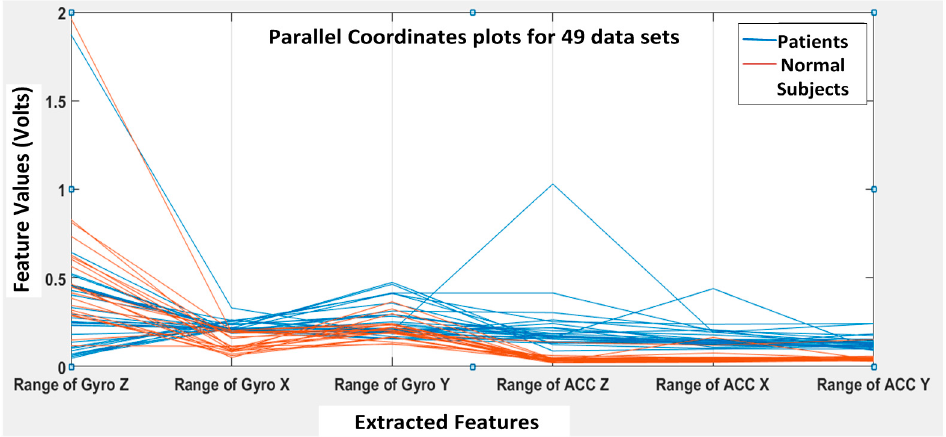
Figure 12. Six extracted features from the WGAS data collected on range (i.e., the difference between maximum and minimum) for four patients and three normal subjects. A total of seven persons each had all seven DGI tests done, so there are 7 × 7 = 49 cases.